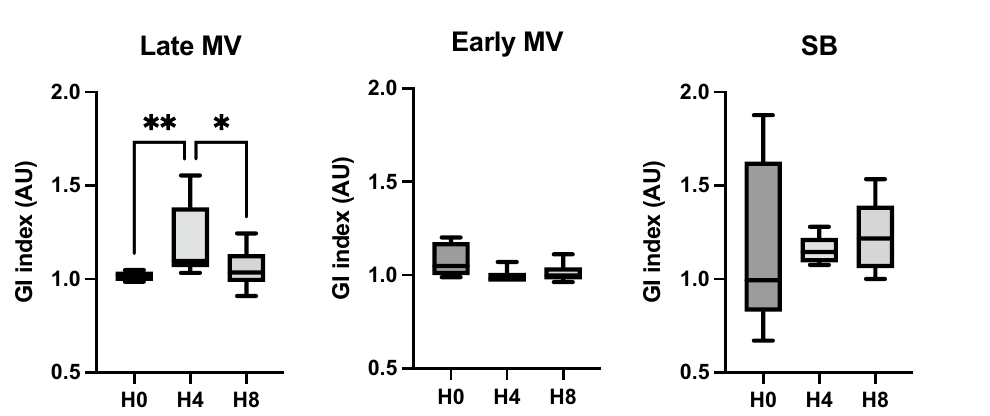
H80.5 H0 H4 Figure 8. Global inhomogeneity index values from SB and Early MV and Late MV groups. MV mechanical ventilation, SB spontaneous breathing, RVD regional ventilation delay, AU arbitrary units. * p < 0.05, using the Friedman test for the Late VM